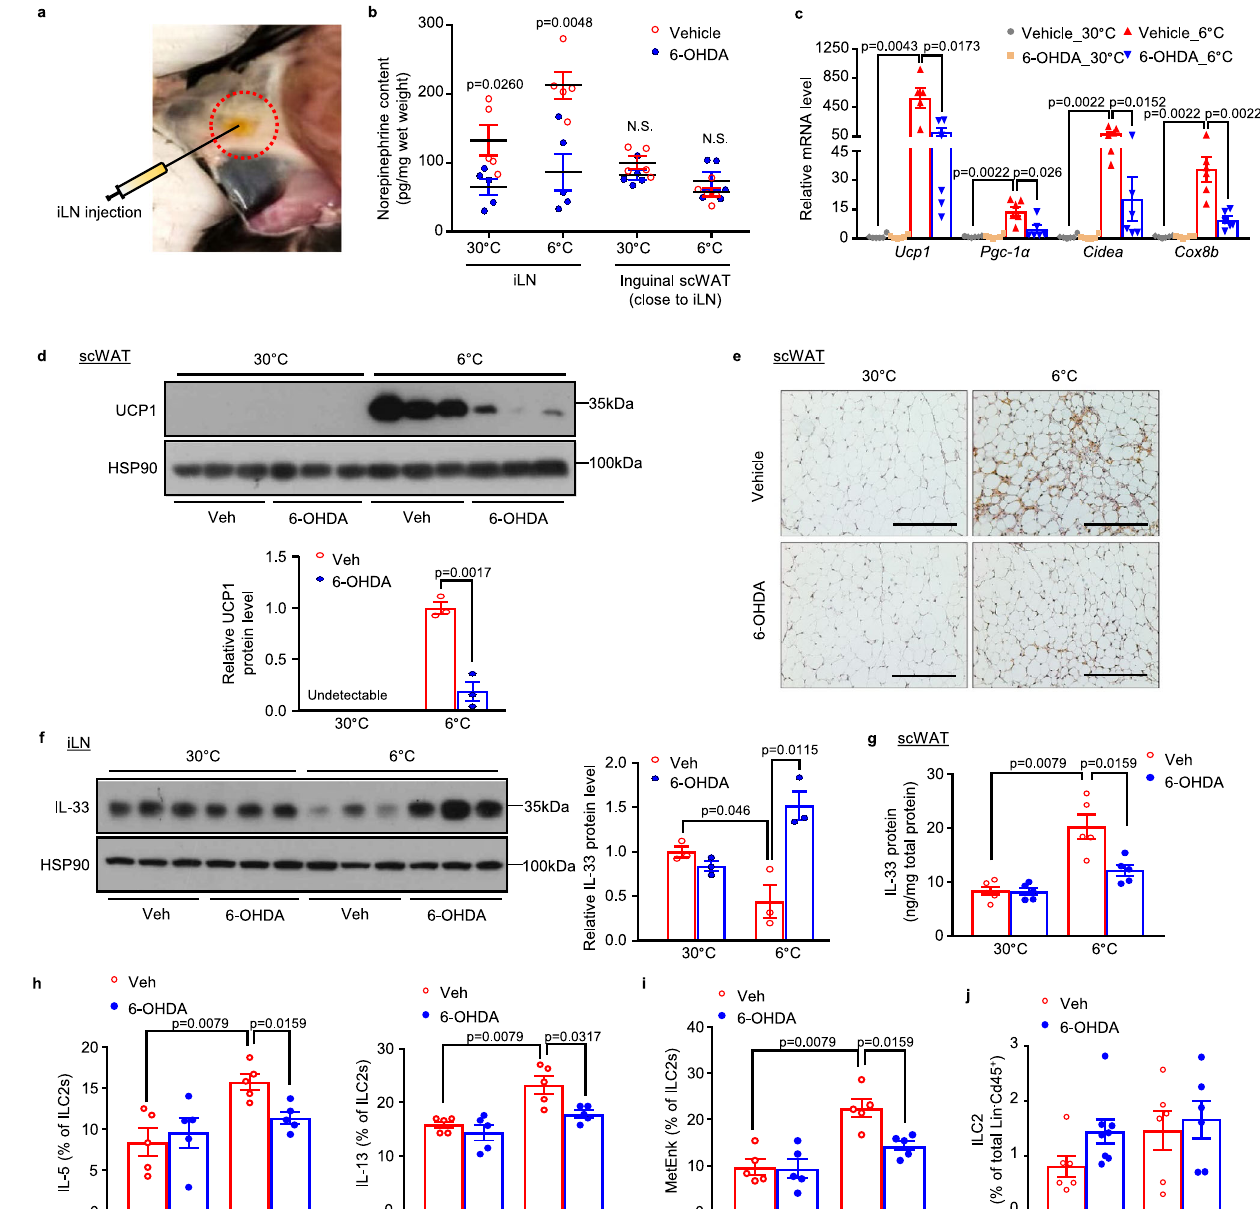
Fig. 6 | Sympathetic denervation of iLN compromises IL-33 release, dampens ILC2 activation and beiging of scWAT in response to cold challenge. Eight- week-old male C57BL/6N mice were subjected to bilateral sympathetic denerva- tion of iLN by local injection of 6-OHDA (9mg/ml in 0.15MNaCl) or 0.15MNaCl (Veh) directly into iLNs. Afterwards, mice were housed at 30°C for 3 weeks fol- lowed by cold exposure (6°C) or continued to be housed at 30°C for another 2 days. a A macroscopic image showing the injection site of iLN embedded in scWAT. b LC/MS-based measurement of norepinephrine content in iLN and its surroundinginguinalscWAT( n =5). c ThemRNAexpressionofthermogenicgenes in scWAT ( n =6). d UCP1 protein level in scWAT (top) and densitometric analysis for the relative abundance of UCP1 normalized with HSP90 (bottom) ( n =3). e Representative images of IHC staining for UCP1 in scWAT. Scale bar, 200 μ m.